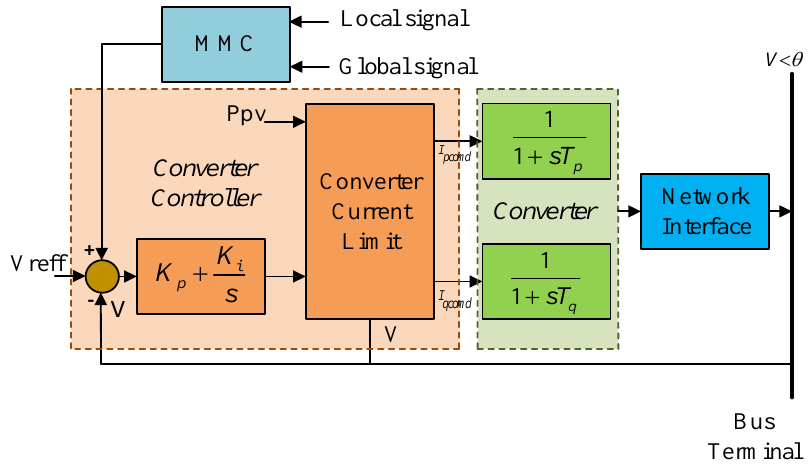
Figure 4. Dynamic model of the PV plant [24].